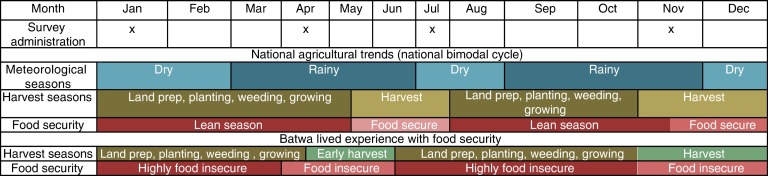
(colour online) Comparison of Southwestern Ugandan seasons and harvesting cycles.
Surveys were administered between January 2013 and April 2014 (Jan 2013, Apr 2013,
Jul 2013, Nov 2013, Jan 2014 and Apr 2014). National data were extracted from the
Global Information and Early Warning System (2015)(

70

) and the Famine Early Warning System Network (2014)(

71

). Batwa data were collected from key informants and focus group
discussions, and validated by cross-referencing with local data from the Uganda
Wildlife Authority for Buhoma and Rushama stations